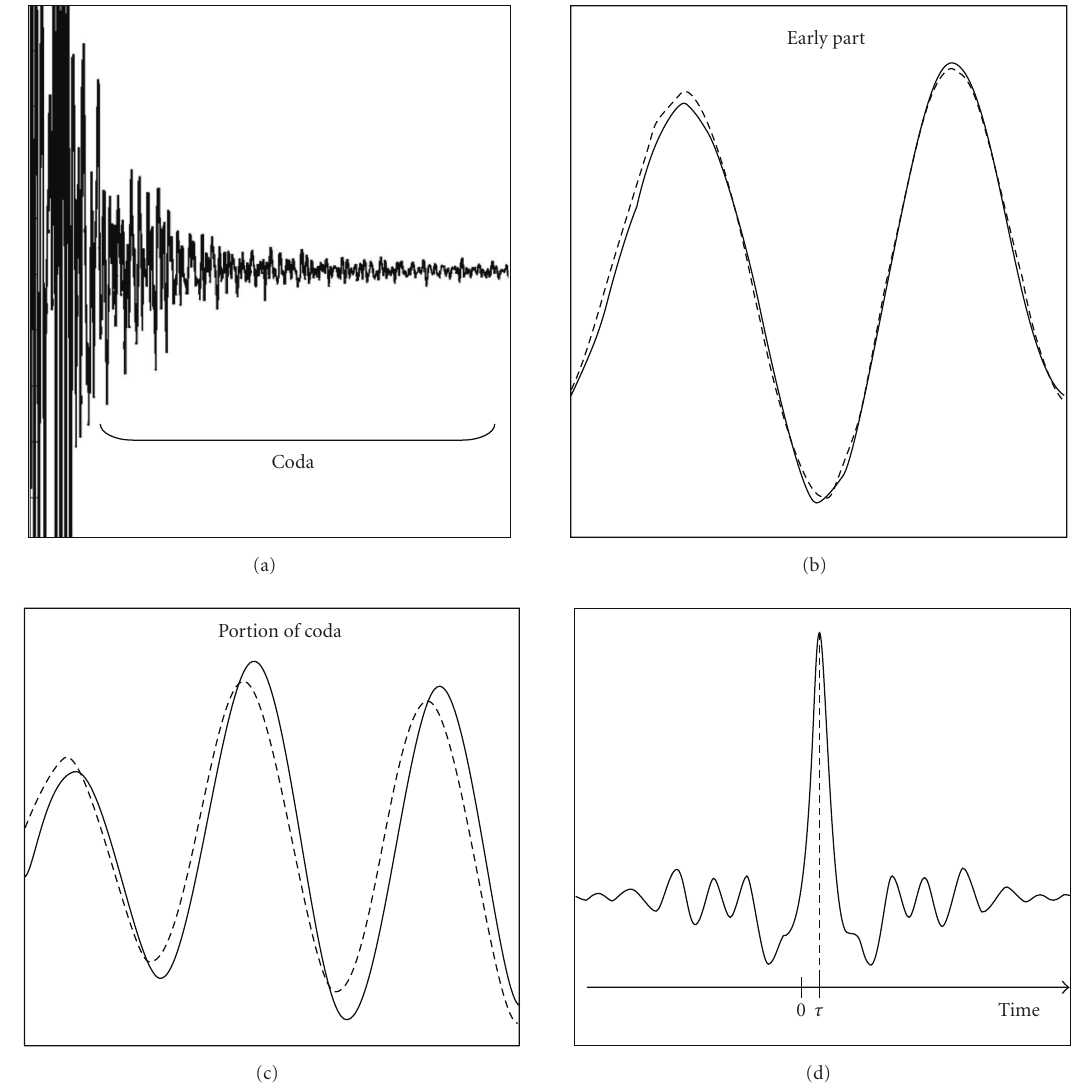
Figure 1: Implementation of the CWI method. Solid line: reference signal. Dotted line: signal under stressed conditions. (a) Typical signals recorded on our sample. (b) Early part of the signal. (c) Portion of the coda. (d) Cross-correlation